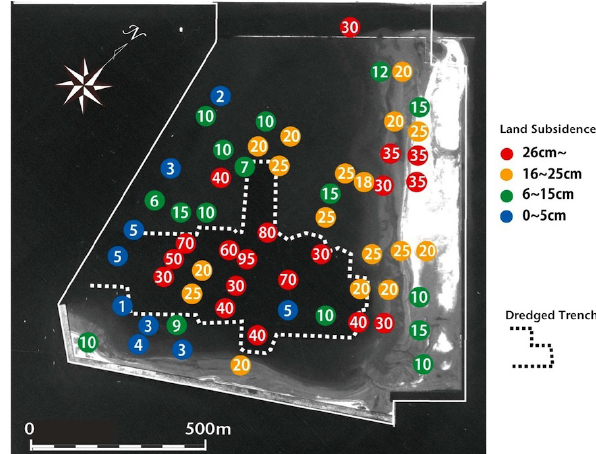
Figure 6. Subsidence values and dredged trench in Chidori block, Urayasu City (RIEGC, 2011).